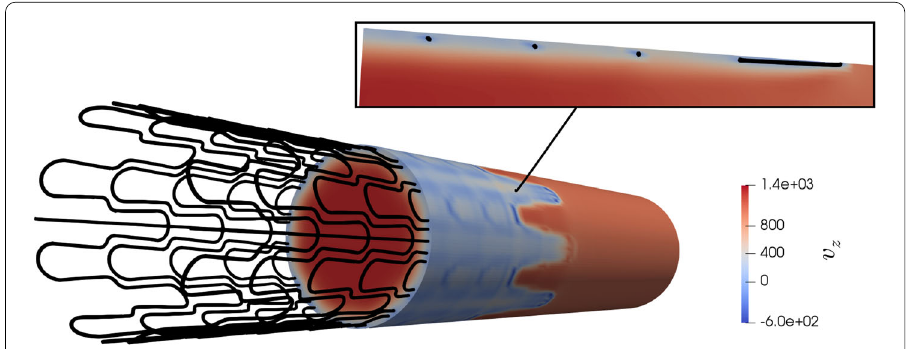
Fig. 19 Final configuration of the stent model problem showing the axial velocity in mm/s and in a slice through the origin at a 45 ◦